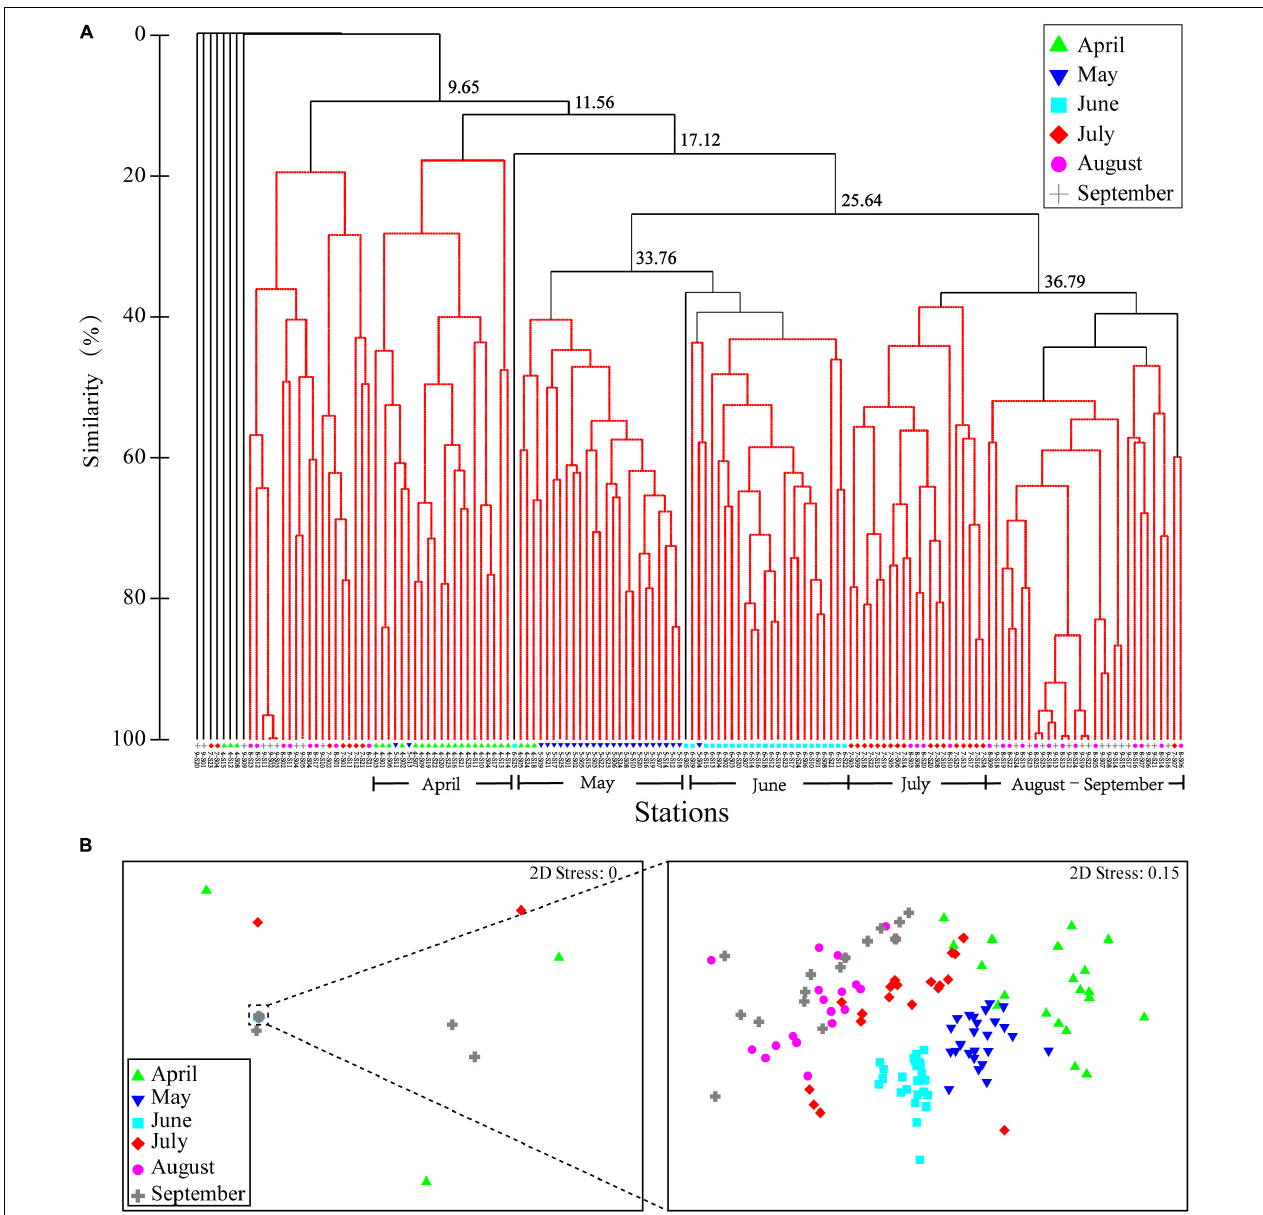
FIGURE 4 | (A) Dendrogram resulting from the cluster analysis and nonmetric multidimensional scaling (nMDS) ordination of spatial and (B) the temporal patterns of ichthyoplankton assemblages in Sansha Bay of Fujian Province, China. Samples were collected from April to September 2019. In panel A, the black lines indicate the significant difference at p ≤ 0.05, and the red lines indicate no significant difference at p >